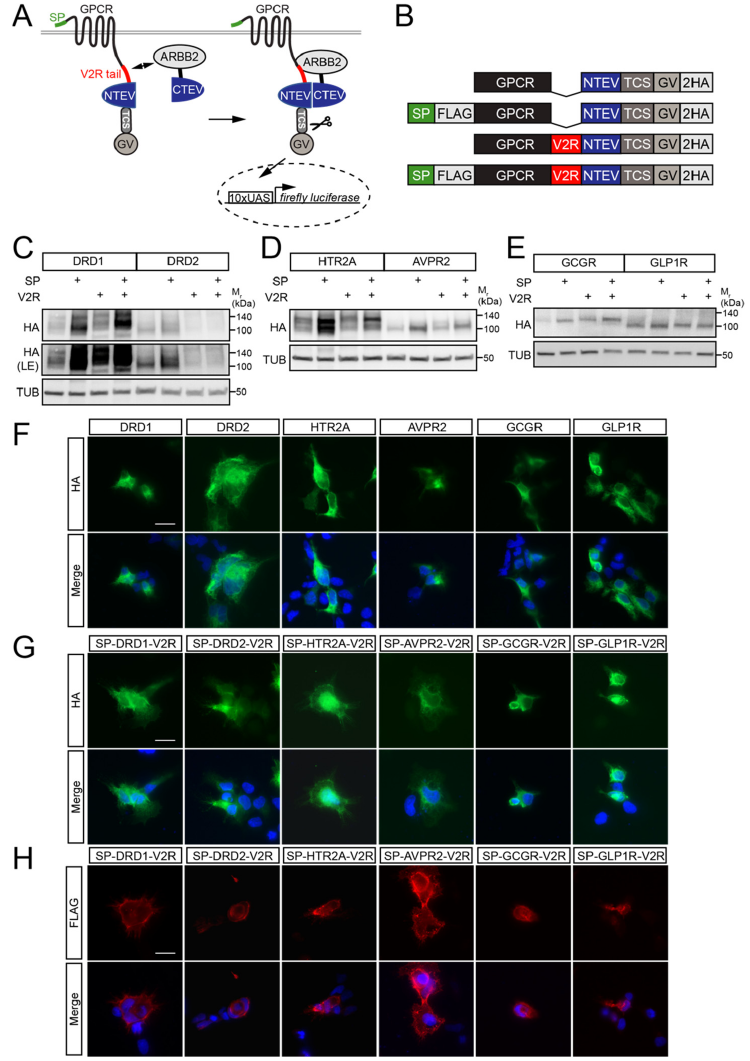
Figure 1. GPCRs for split TEV β -arrestin-2 recruitment assays were modified by the addition of a signal peptide, a V2R tail, or both. ( A ) Scheme of the GPCR β -arrestin-2 split TEV recruitment assay. A GPCR could be fused to the signal peptide (SP) and/or the tail of vasopressin receptor 2 (V2R) to test assay performance. ARRB2, β -arrestin-2; TCS, TEV protease cleavage site. ( B ) Graphical representation of the split TEV GPCR fusions. Depicted are the four variants of the GPCRs tested: native GPCR, SP-GPCR fusion, GPCR-V2R fusion, and SP-GPCR-V2R fusion. FLAG, single FLAG tag; NTEV, N-terminal moiety of the TEV protease; TCS, TEV protease cleavage site; GV, synthetic co-transcriptional activator GAL4-VP16; 2HA, double HA tag. ( C – E ) Split TEV GPCR constructs were properly expressed in HEK-293 cells. Western blots of the split TEV GPCR fusion constructs for DRD1 and DRD2 ( C ), HTR2A and AVPR2 ( D ), and GCGR and GLP1R ( E ). All proteins were detected with an HA antibody. LE, longer exposure. ( F – H ) Surface expression of selected GPCR split TEV fusions using immunocytochemistry staining. Native GPCR split TEV fusions were stained against the cytosolic HA epitope ( F ). SP-GPCR-V2R split TEV fusions were stained against the cytosolic HA epitope ( G ) and an extracellular FLAG epitope that was located C-terminal to SP ( H ). Note that FLAG staining was performed without permeabilizing cells. The merge was Dapi and antibody staining. Scale bar = 20 µM.